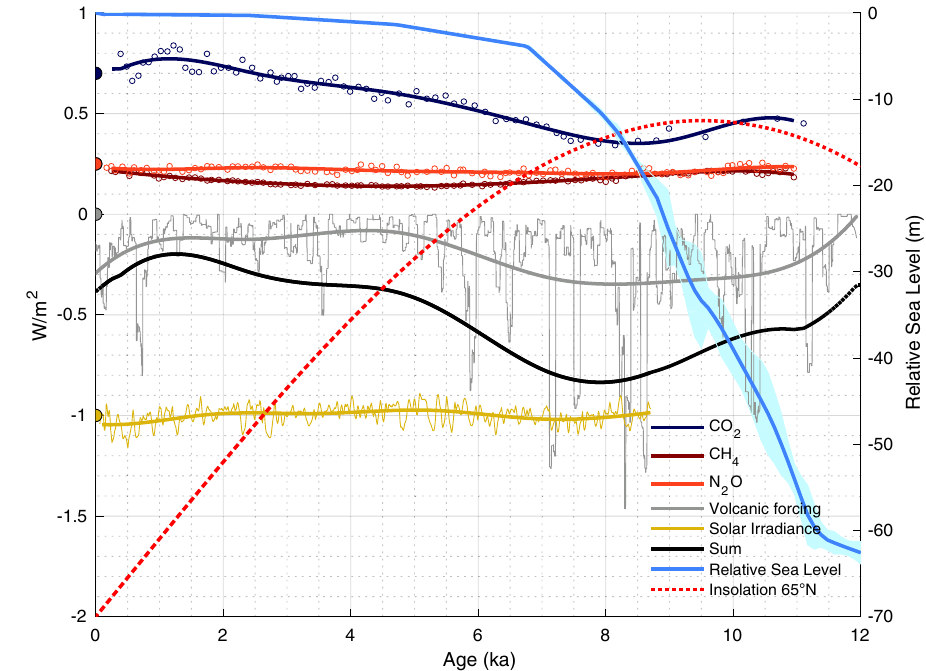
Fig. 8 | Holocene forcing. Forcing (W/m 2 ) due to pCO2 43 ; pCH 4 and pN 2 O 44 ; 100- year running mean of volcanic radiative forcing 41 ; decadal total solar irradiance variations 42 at earth surface ( Δ TSI at the top of the atmosphere × (1 – albedo)/4, with mean albedo =0.29), mean annual insolation at 65°N 48 – 50 , and relative sea level 47 . Preindustrial forcing is shown as a fi lled dot at 0ka; CH 4 and N 2 O are